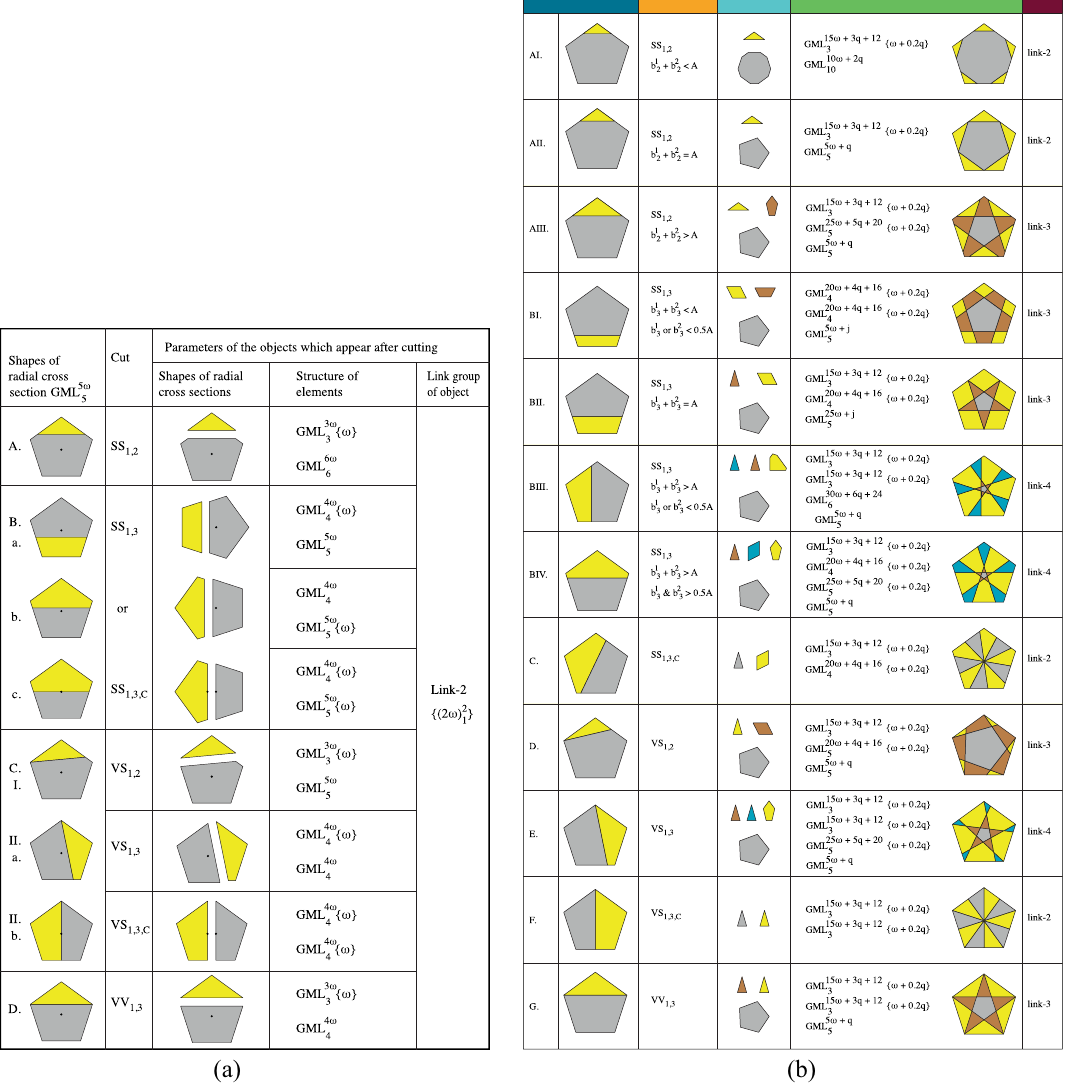
, (b) GML n . Number, shape and twisting of resulting bodies and their link number [5]. Different 5 5